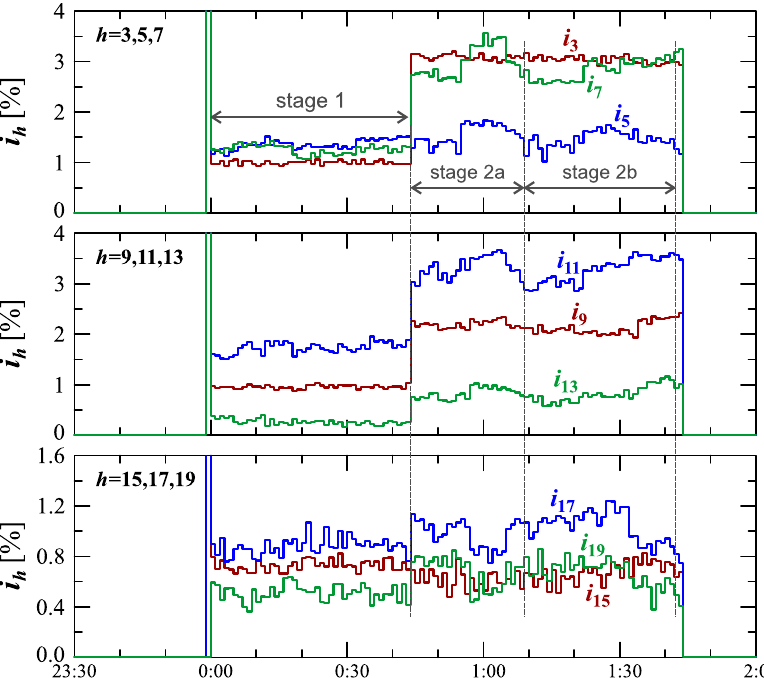
Figure 8. The characteristics of odd harmonics of the current i h = f ( t ) from the order h = 3 to 19 for Case I.